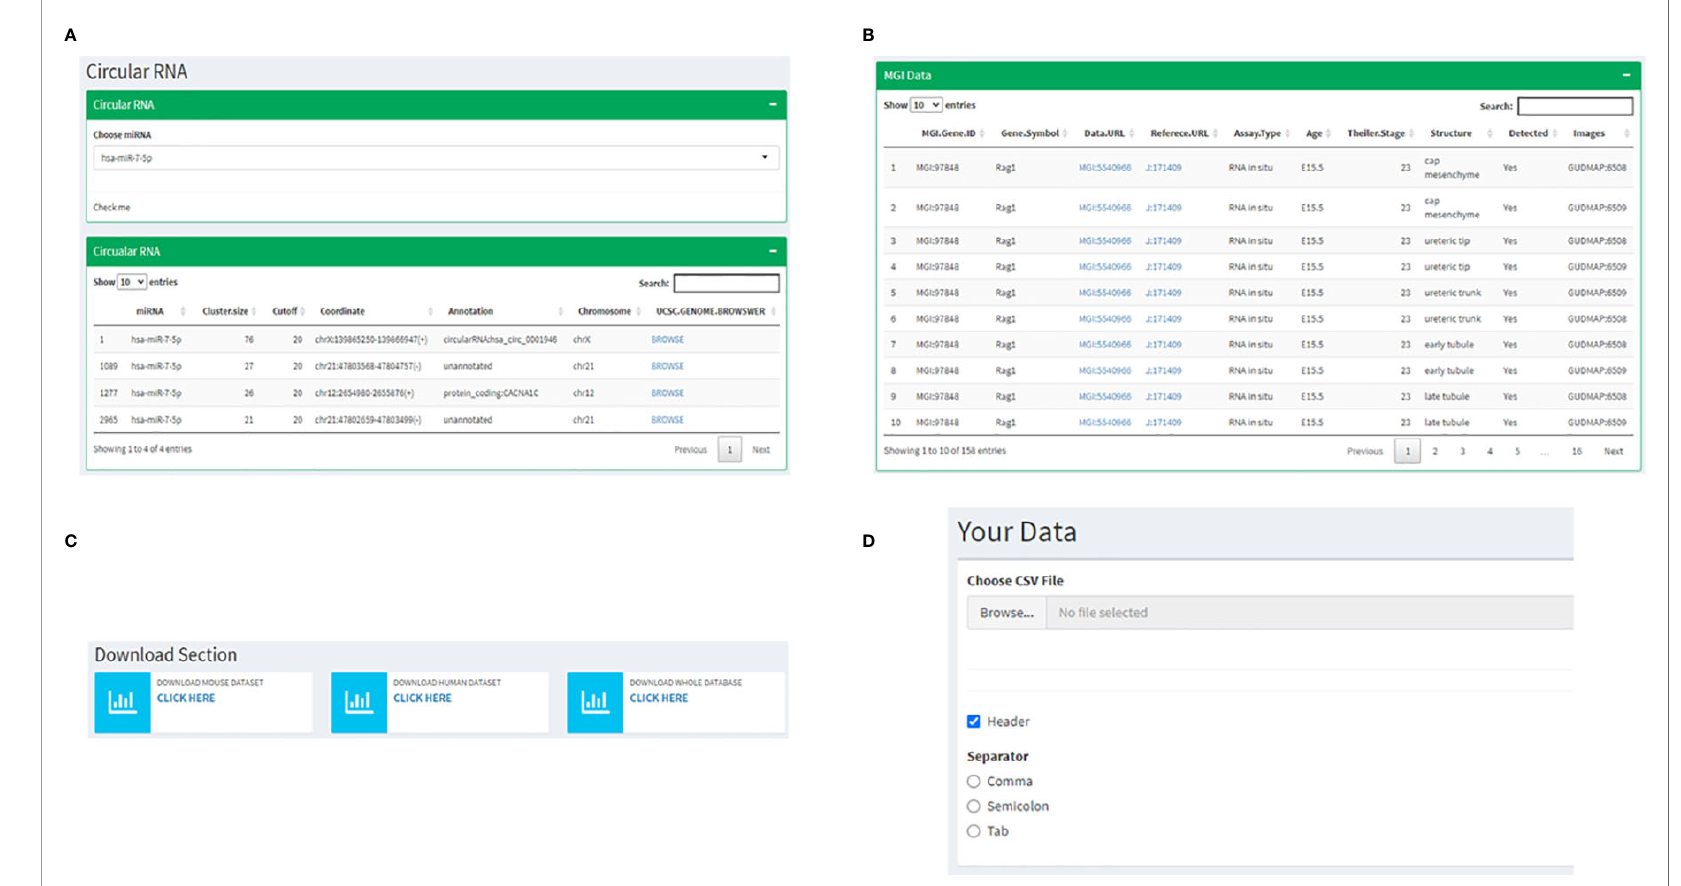
FIGURE 6 | Instances of subsequent pages where (A) shows the utility of miRNA dropdown menu and a corresponding table listing the UCSC links to corresponding circRNA chromosomal locations; (B) represents the MGI page depicting a table with links to information related to RAG1 from the MGI database; (C) shows the page where all the data from the database can be downloaded and (D) represents the interactive utility where the users have an option to visualize their own data by uploading fi